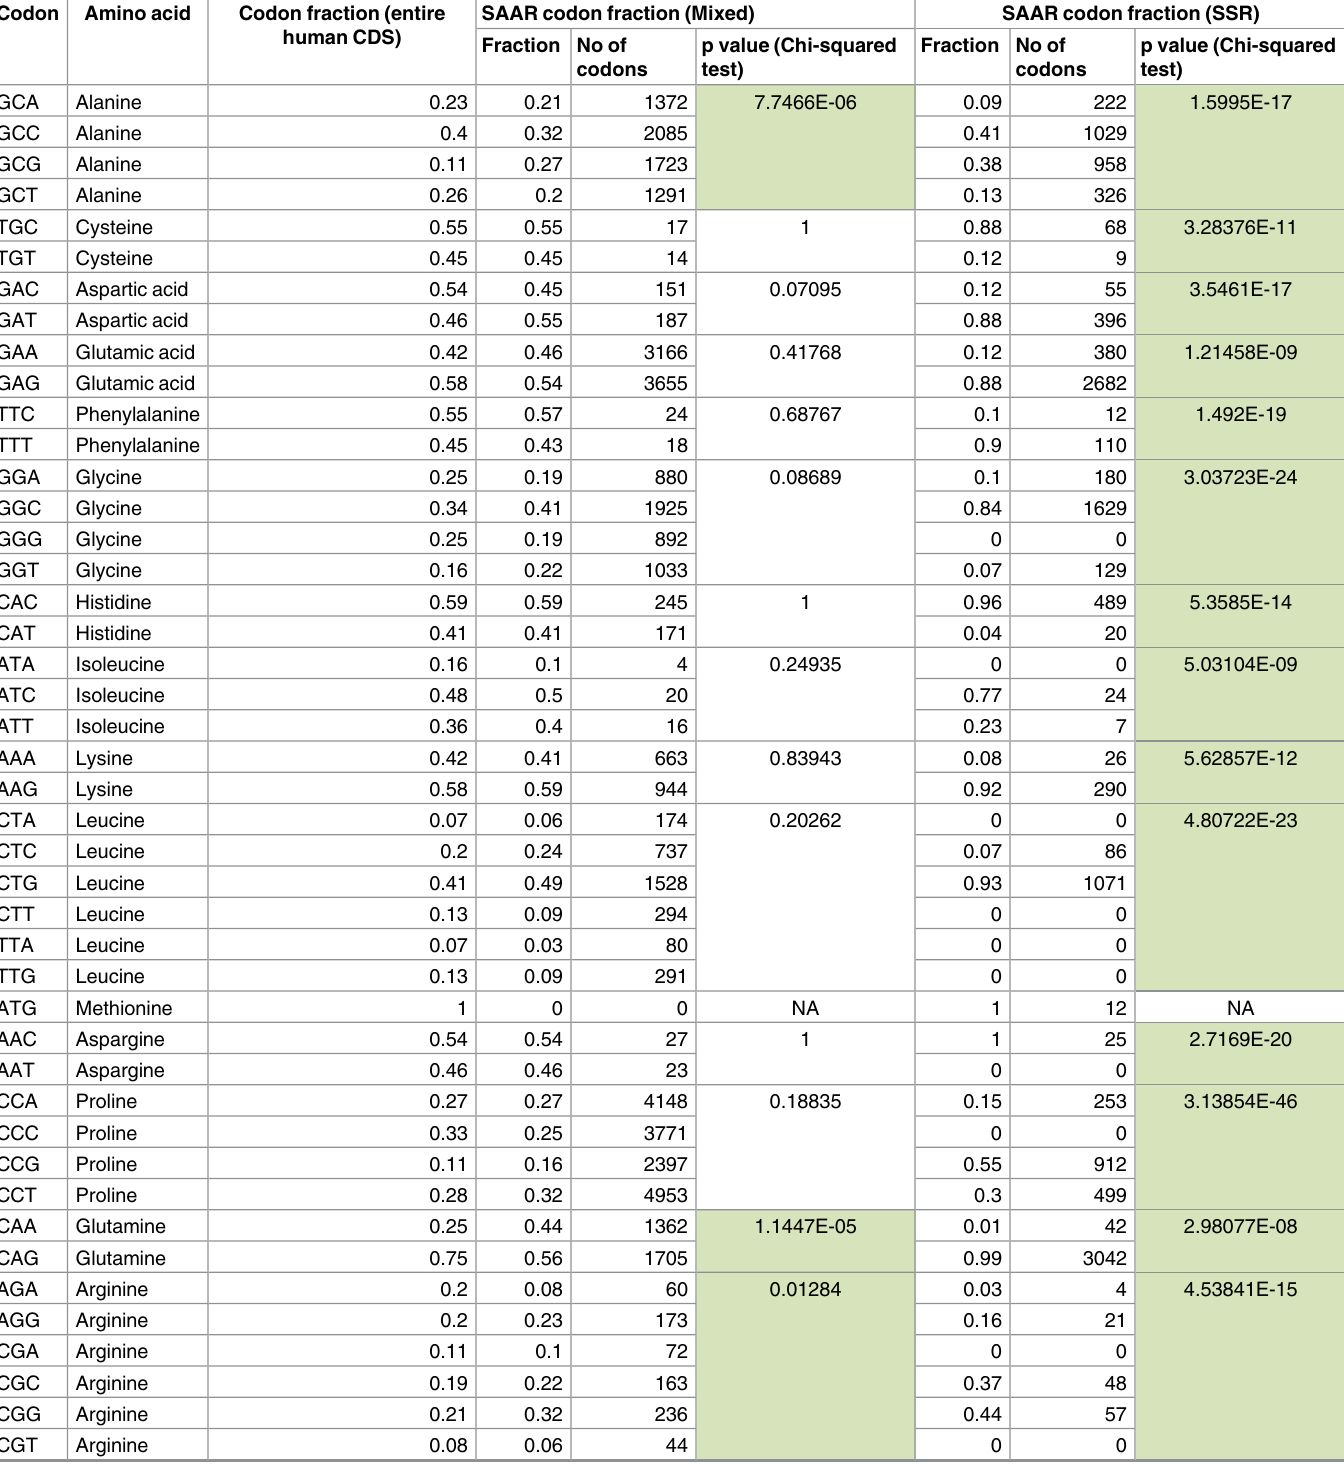
Table 2. Codon fraction for SAAR coding regions against codon fraction of CDS in the human genome. Codon Amino